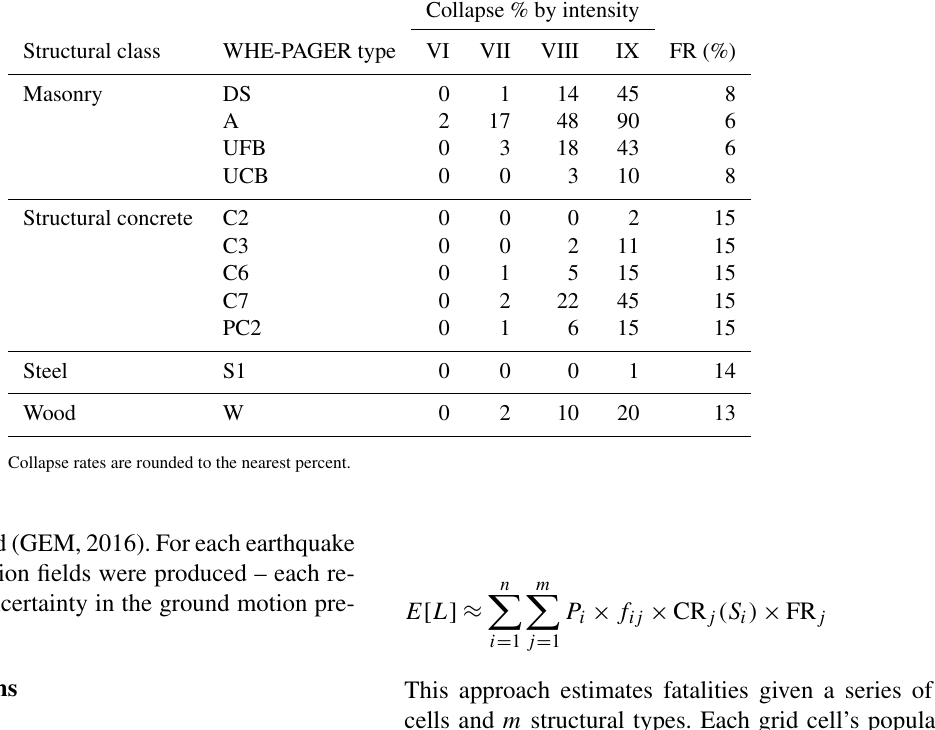
Table 2. Collapse rates and fatality rates by structural type. Structural class